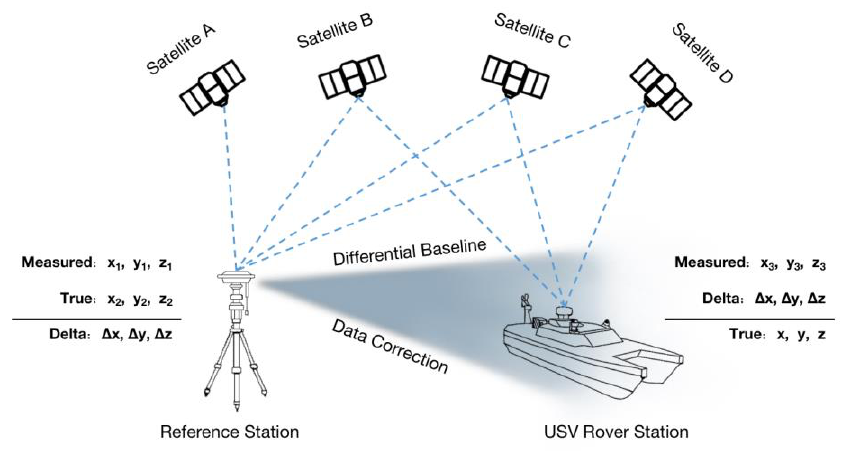
Figure 2. Structure of carrier phase differential GNSS system.